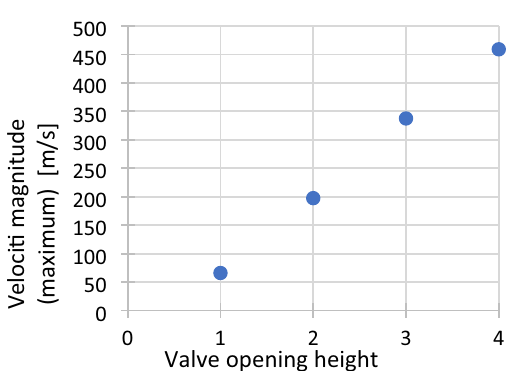
Figure 9. Maximum speed for various configurations of the valve opening height for: Where: 3 m, 2 h 3.95 10 1 1 − − = ×